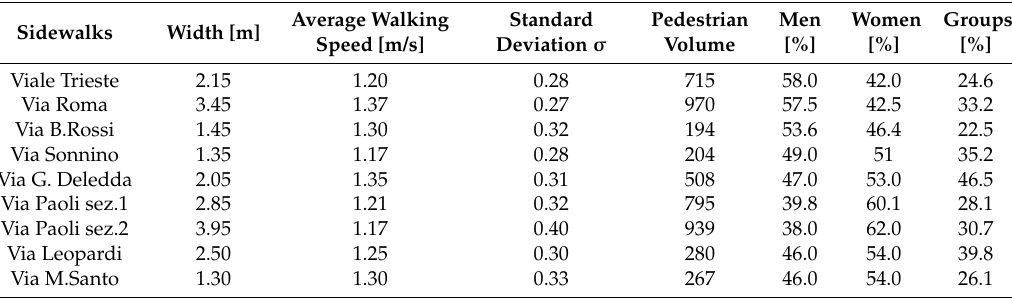
Table 1. General sidewalk